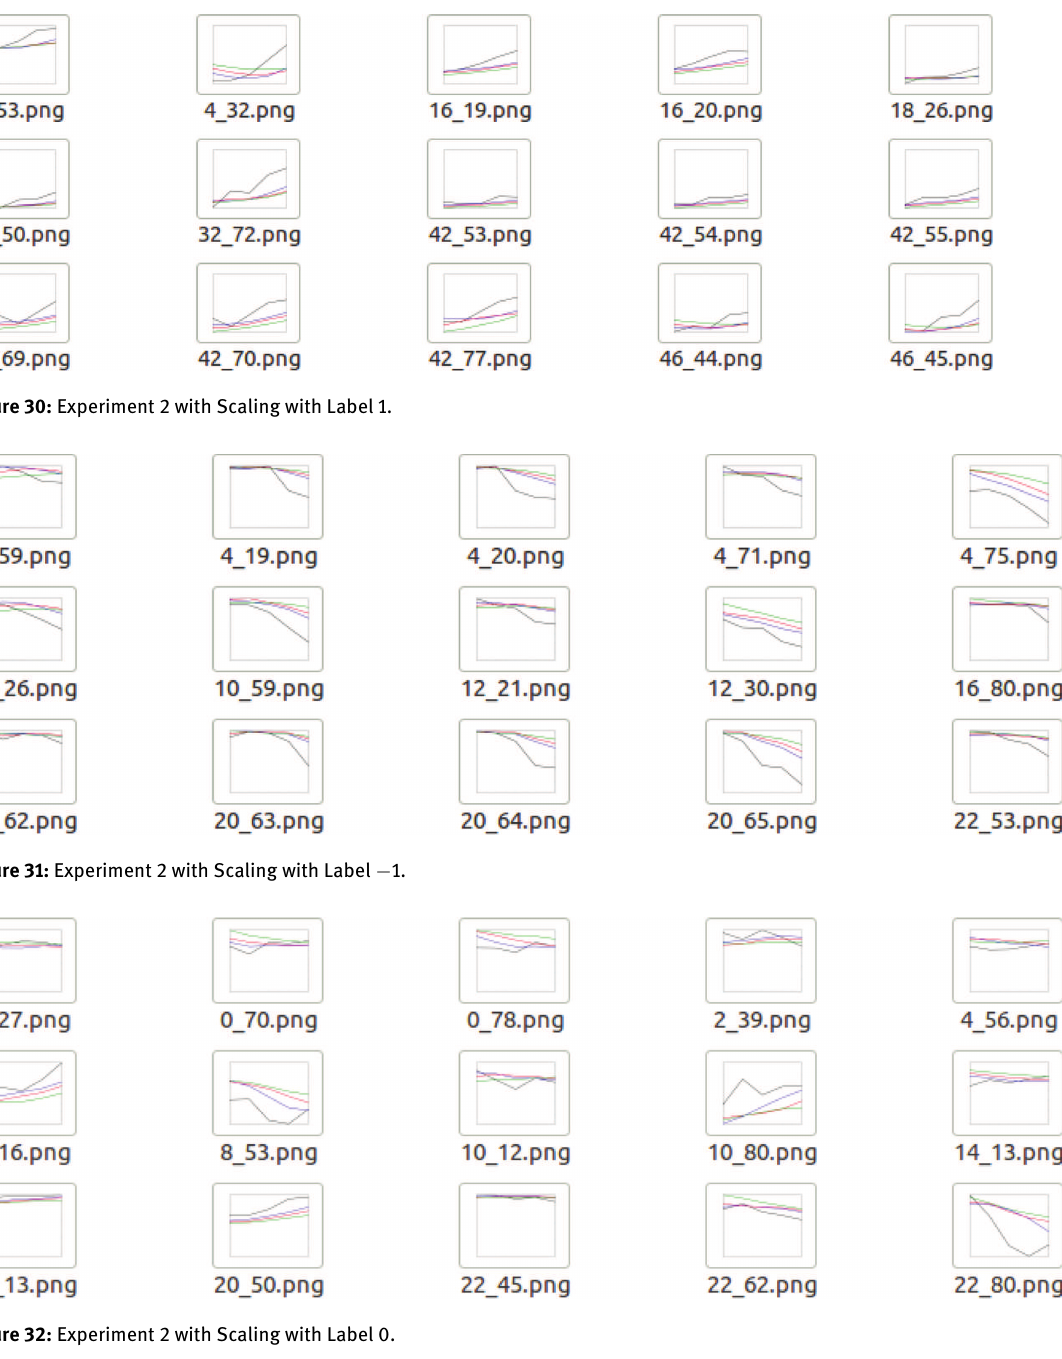
Figure 32: Experiment 2 with Scaling with Label